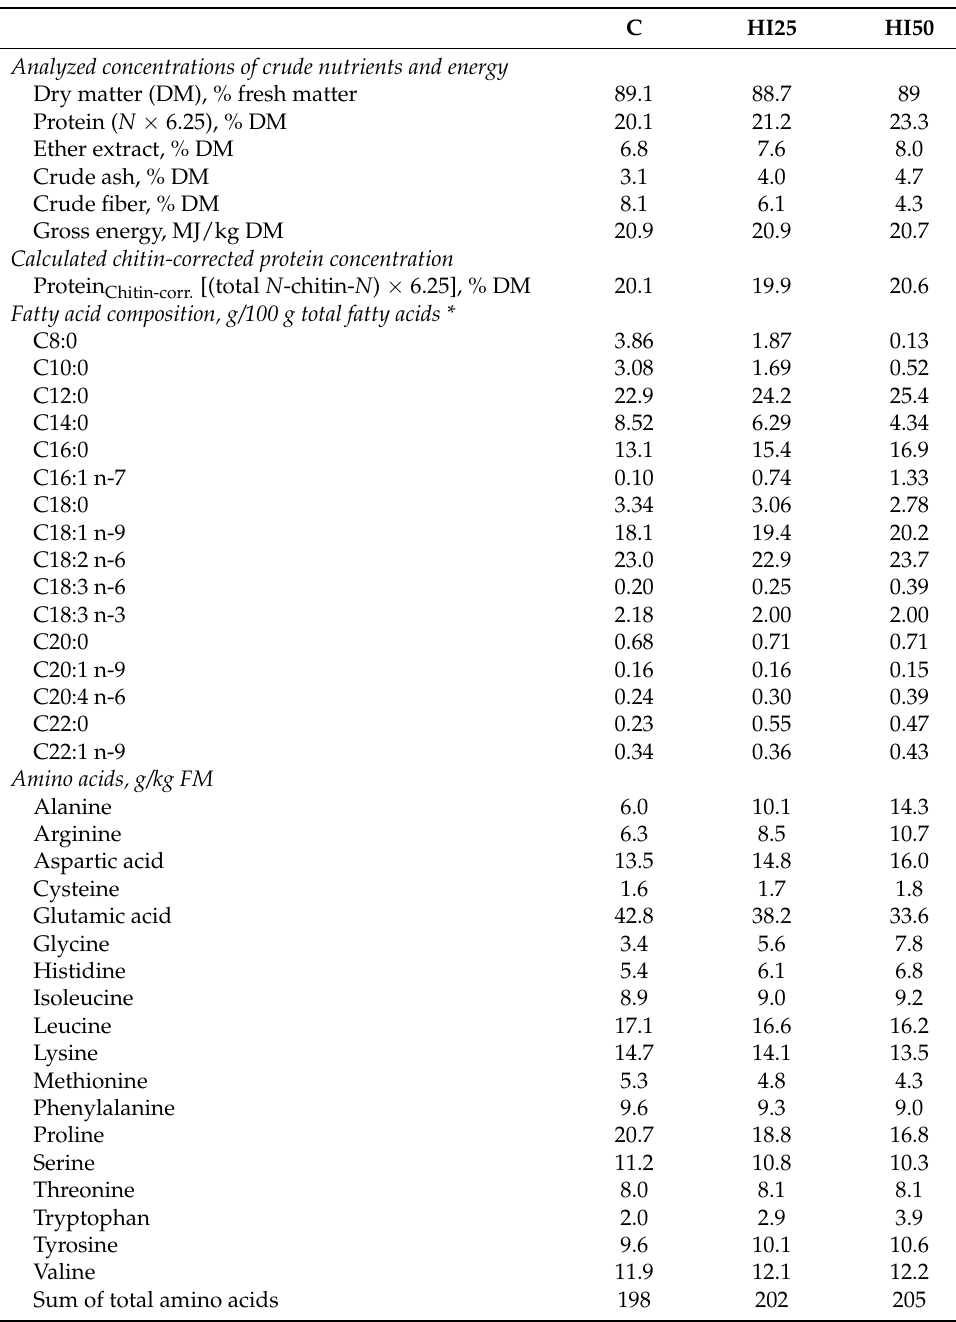
(Table 4). The weights of M. soleus and M. gastrocnemius were higher in group L-C than in group O-C ( p < 0.05) but were not different across the obese groups. Table 3. Concentrations of crude nutrients and energy, total lipid fatty acid composition and amino acid concentrations of the experimental